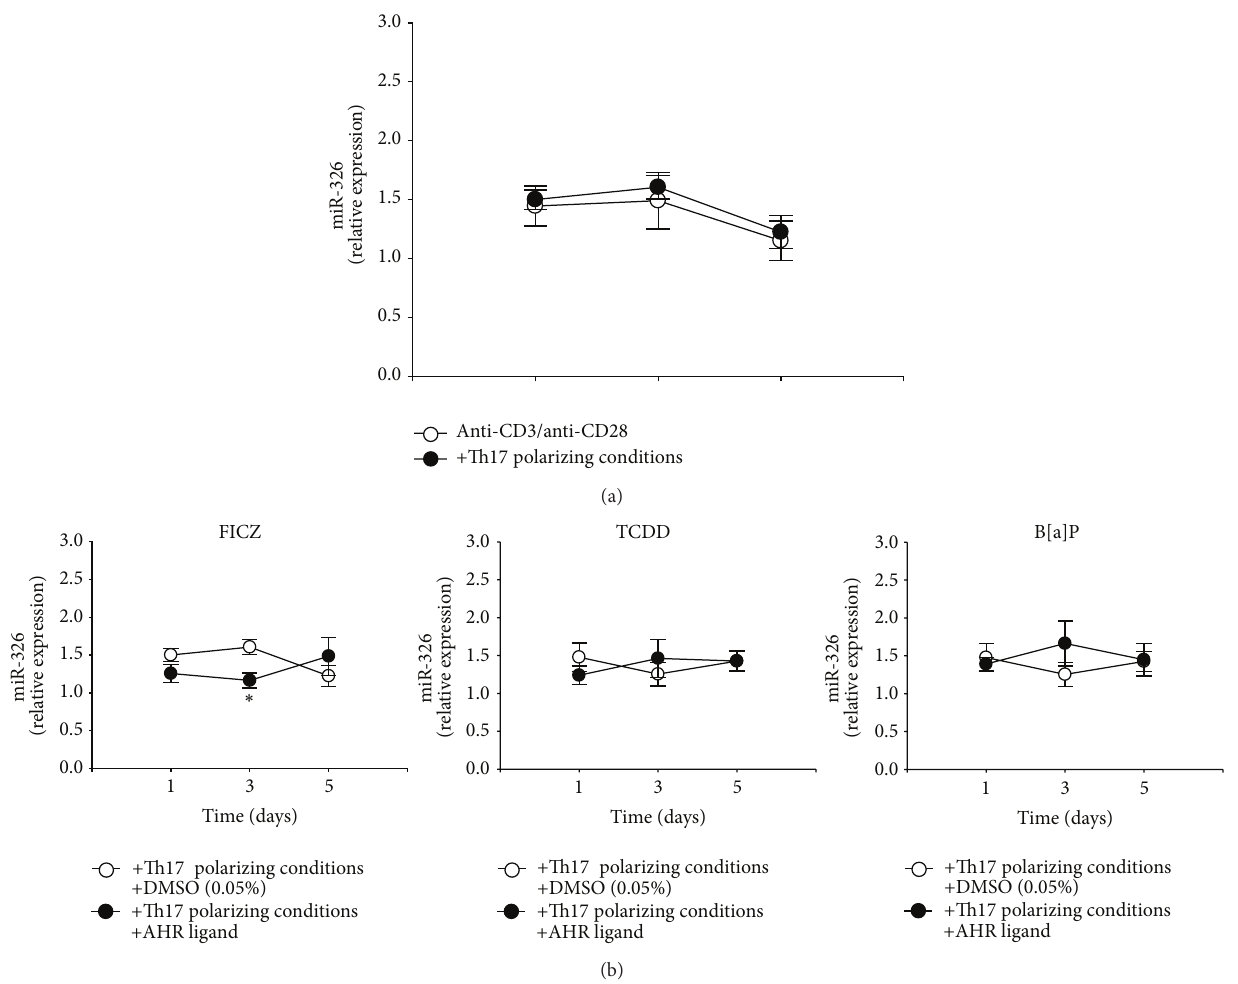
Figure 7: FICZ changes the expression of the Th17 associated microRNA miR-326. (a) The expression of microRNA hsa-miR-326 in CD4 +